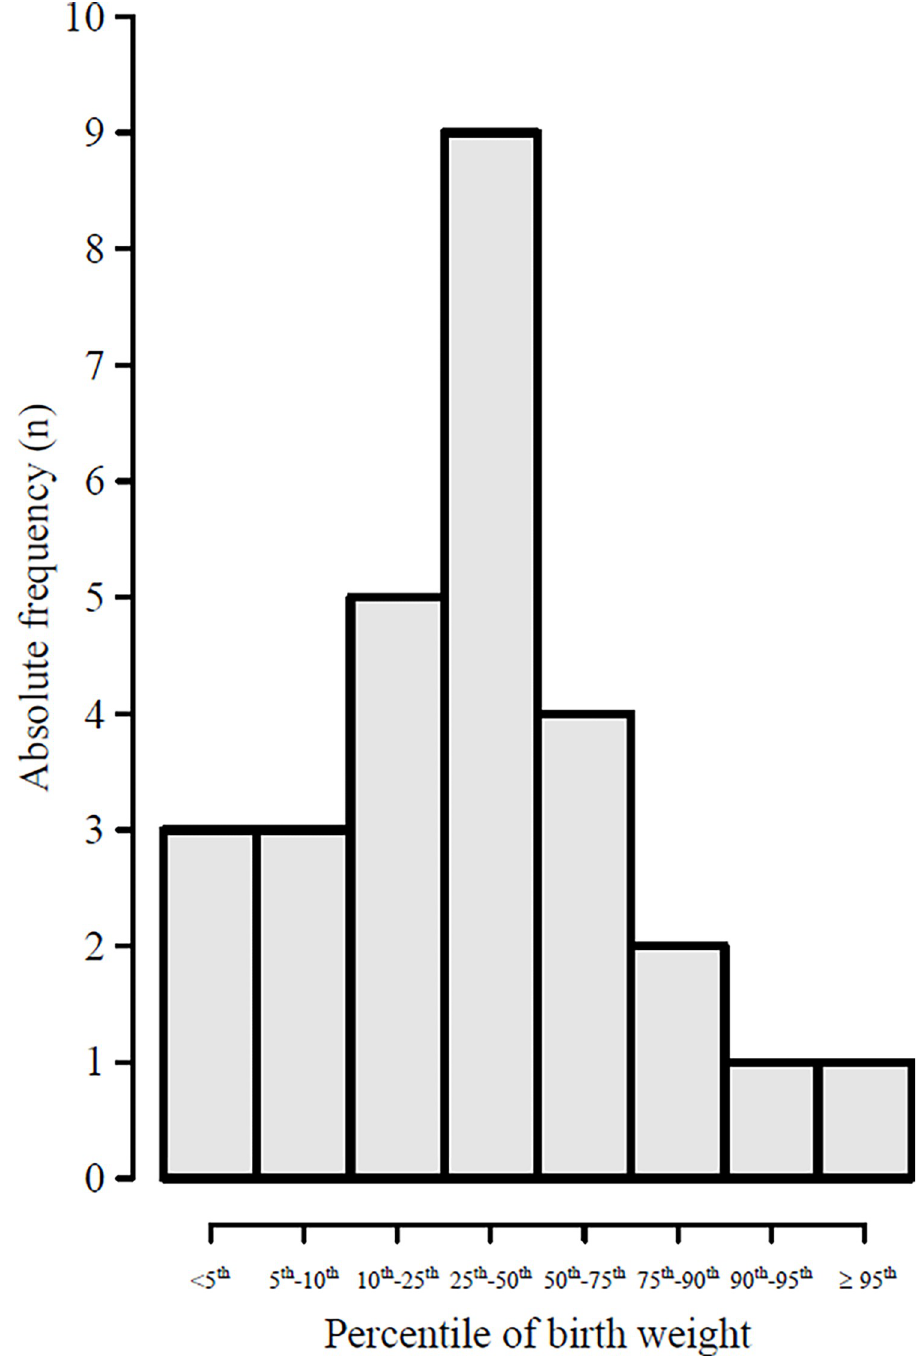
Fig 3. Birth weight percentile of cases of intrauterine